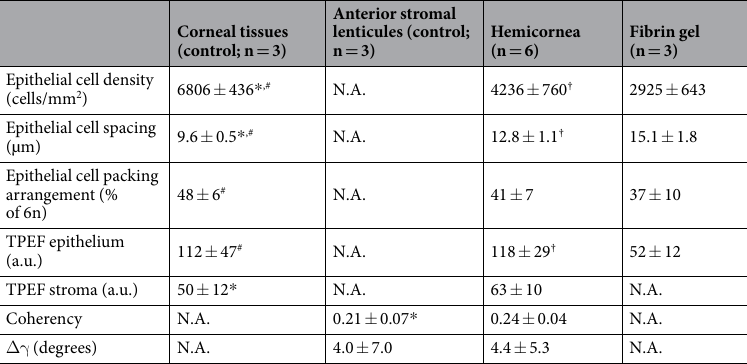
Anterior stromal lenticules (control; n = 3)